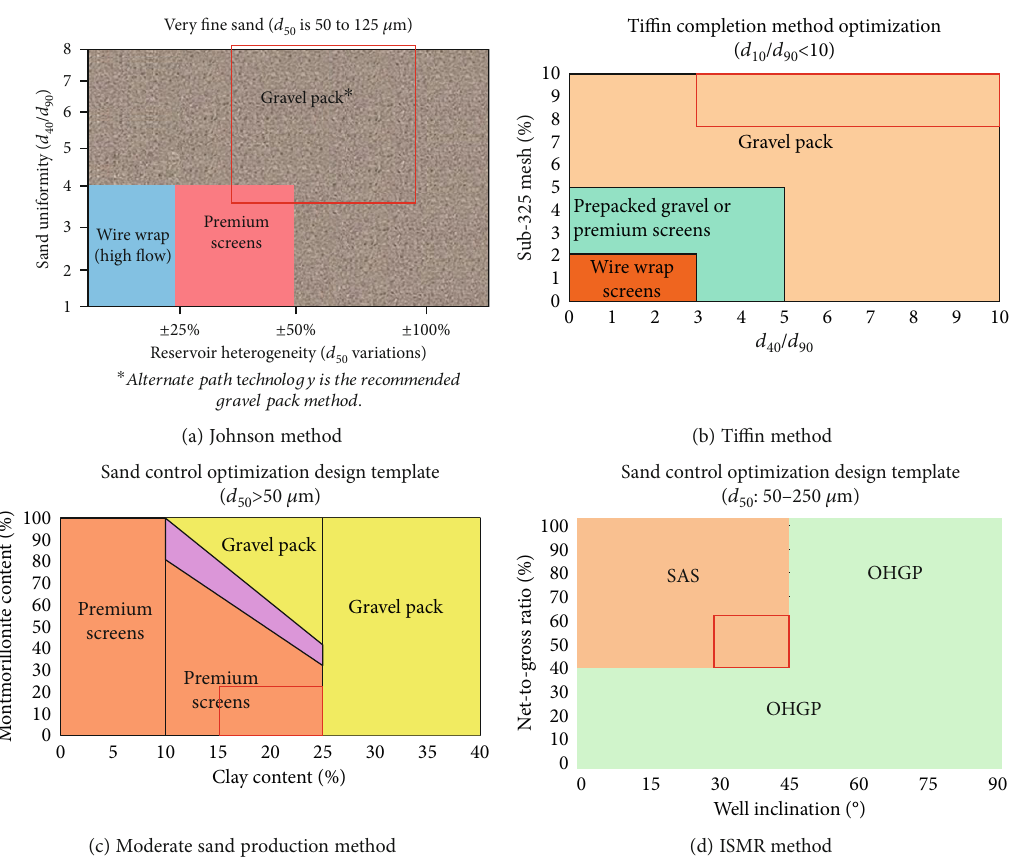
Figure 13: (a) Johnson method, (b) Ti ffi n method, (c) moderate sand production method, (d) ISMR